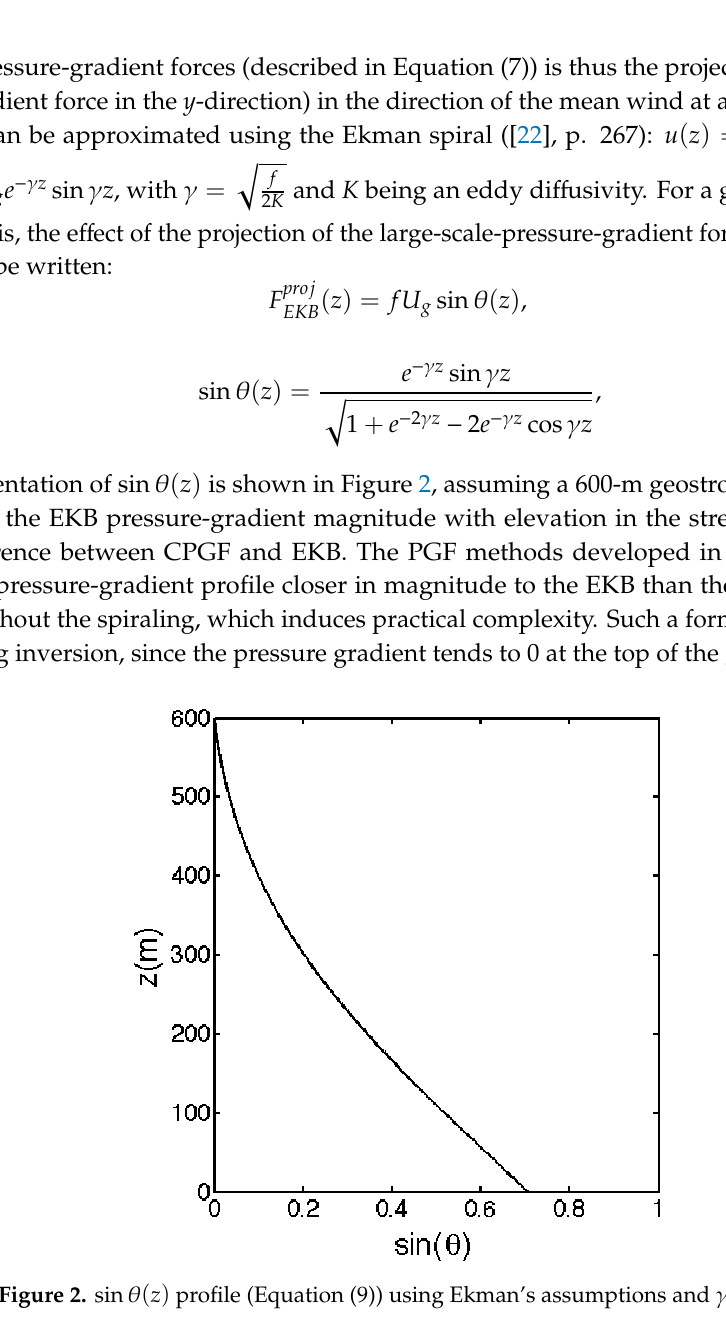
600 . (cid:2874)(cid:2868)(cid:2868)